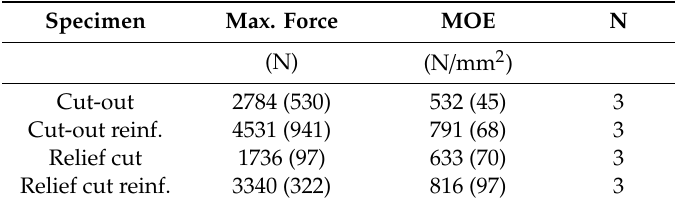
Table 4. Results of the bending test (SD in